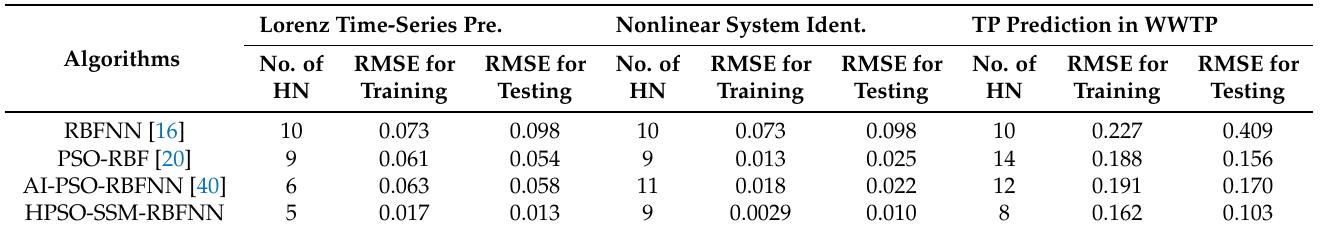
Table 2. Comparing the performance of suggested algorithms with conventional approaches. Lorenz Time-Series Pre. Nonlinear System Ident. TP Prediction in Algorithms